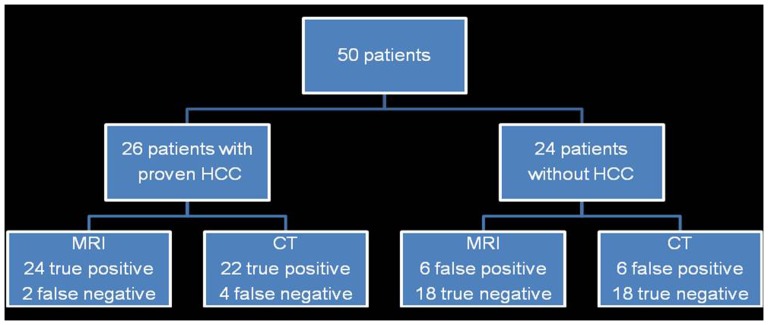
Flow chart for identification of patients with HCC in MRI and CT.